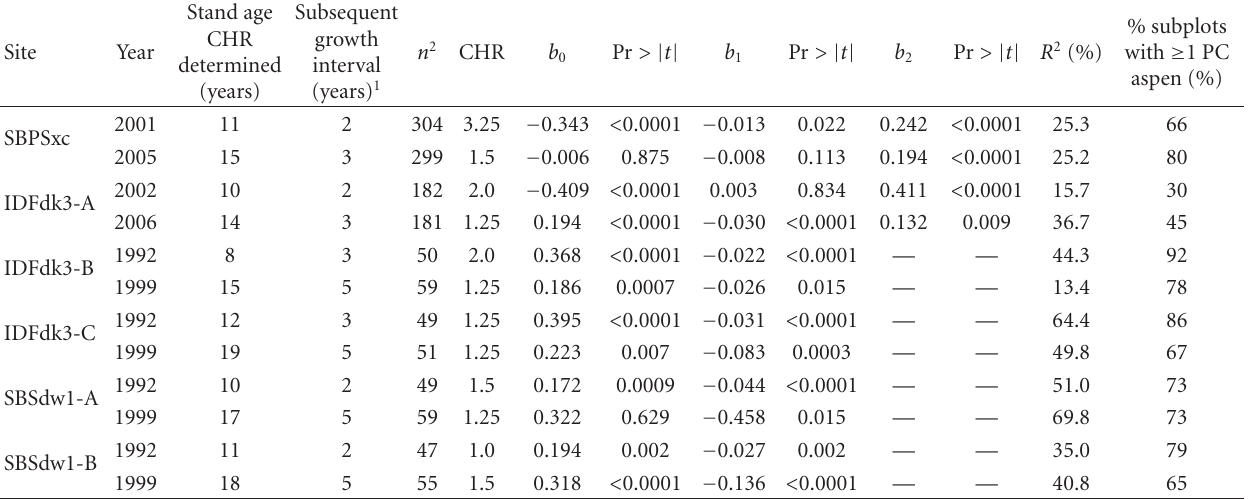
Table 2: Critical height ratio (CHR) model coe ffi cients, correlation coe ffi cients ( R 2 ), and the proportion of subplots having at least one principal competitor (PC)